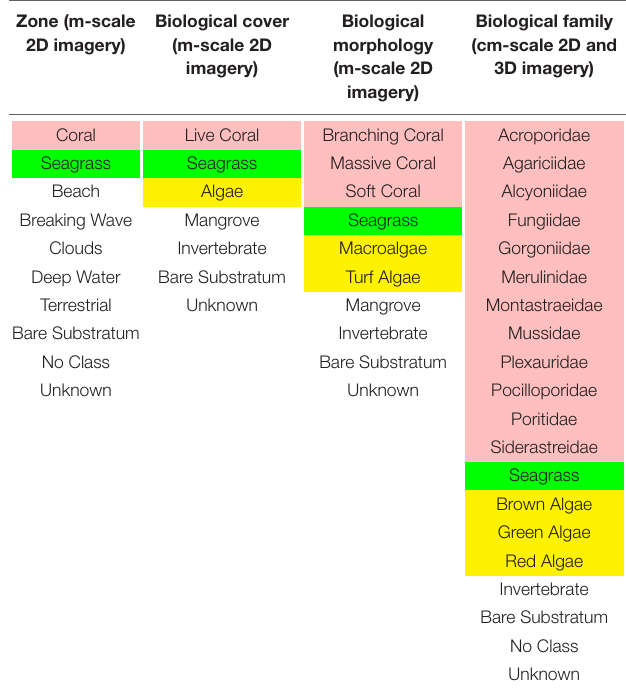
TABLE 1 | NeMO-Net classification